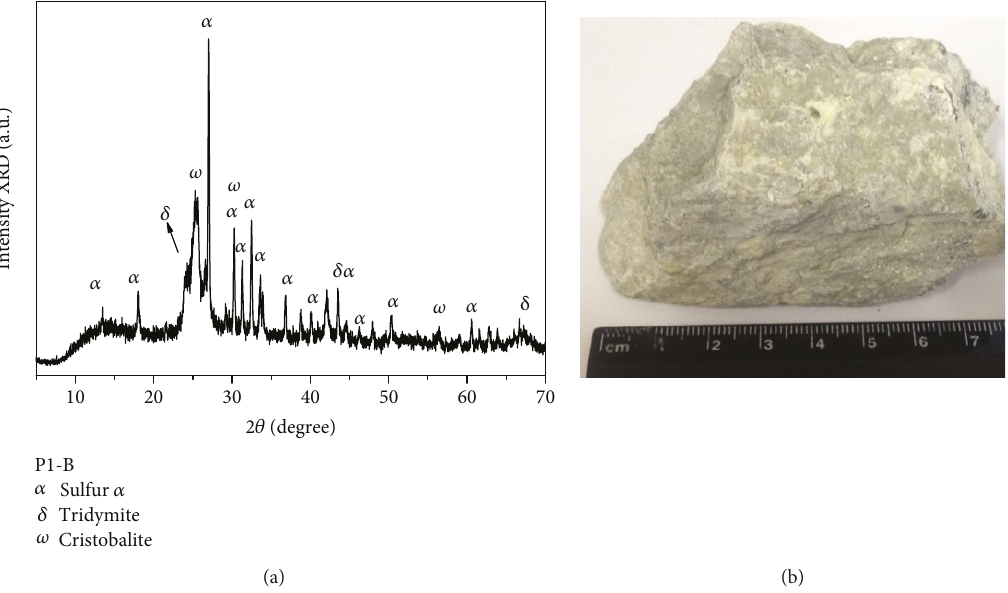
Figure 10: Sample P1-B (a) XRD patterns and (b) rock sample of crystalline tu ff